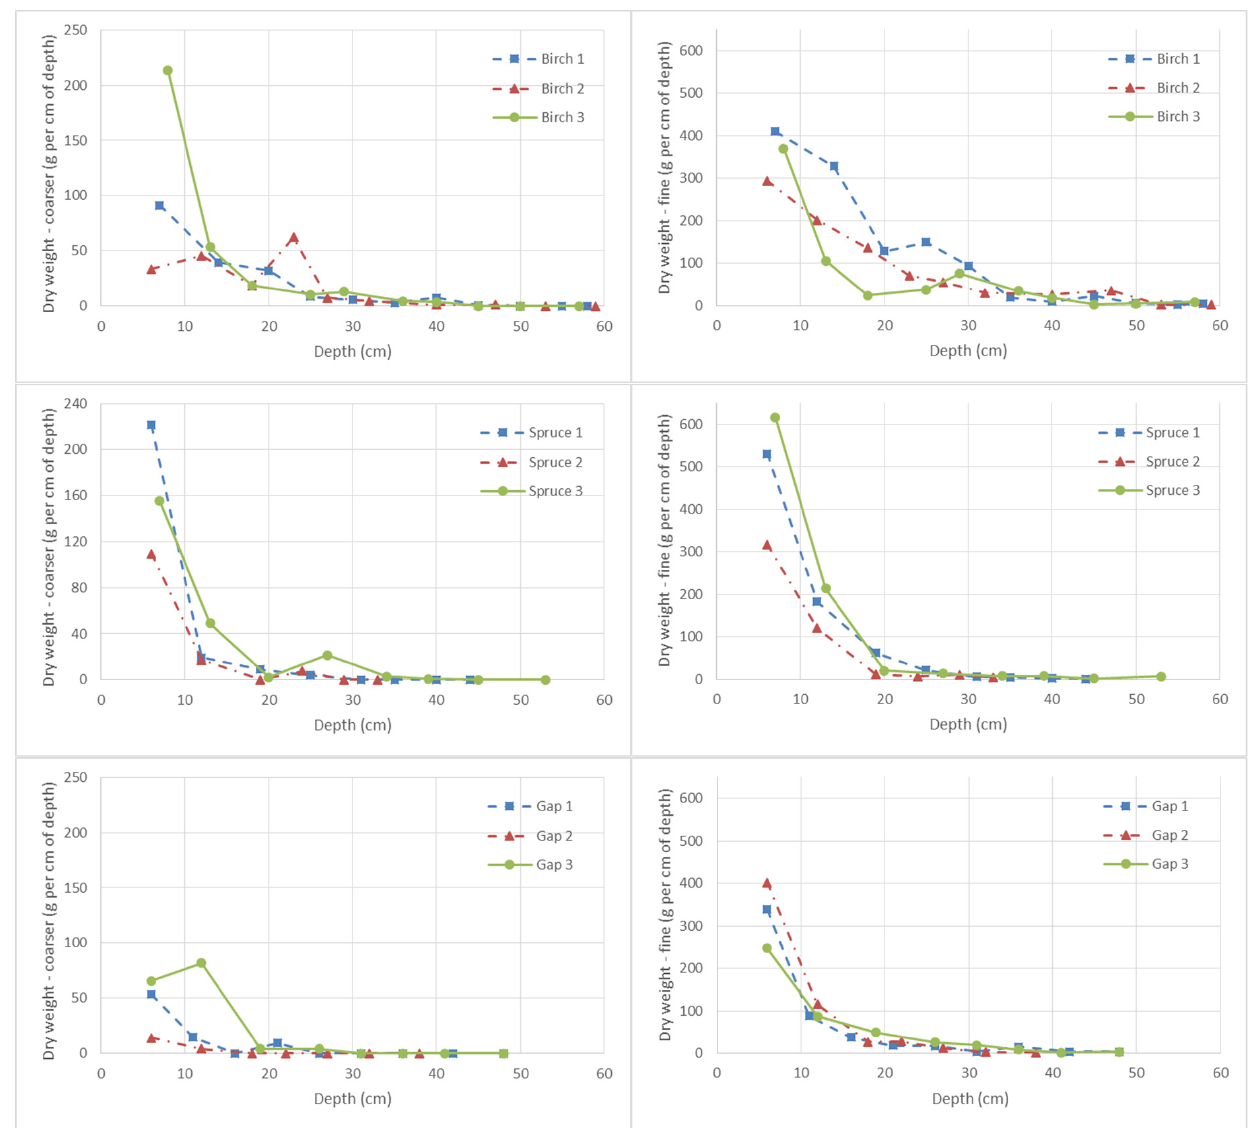
Figure 4. Average dry weight (g) of coarser ( left ) and fine ( right ) roots per cm of depth of the respective soil layer on an area of 1 m 2 .